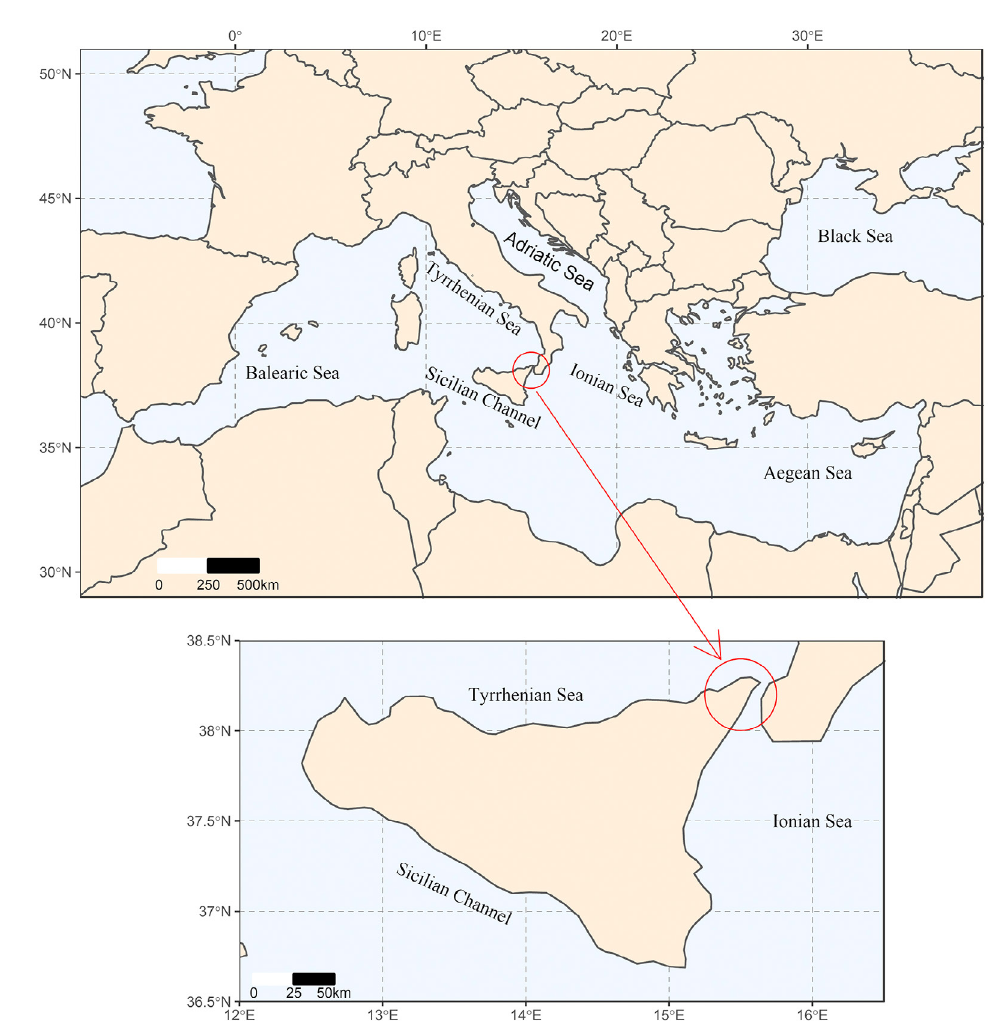
Fig. 1. – Trachinotus ovatus collection areas in the Strait of Messina, central Mediterranean